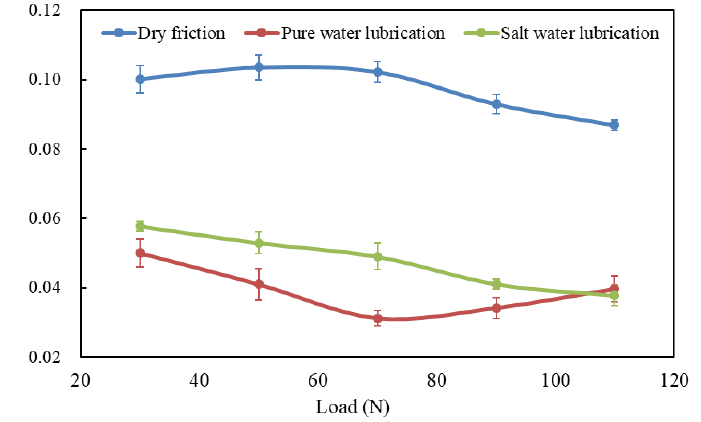
Figure 3. Variation of friction coefficients of UHMWPE with load at 500 r/min speed under different friction conditions.